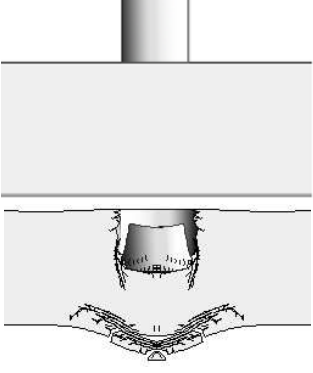
Fig. 2. Steel impactor and aluminum plate before ( t = 0 µs) and after impact ( t = 30 µs). Fragment initial and current configurations. Experimental data by A.Bragov and V. Zaharov.